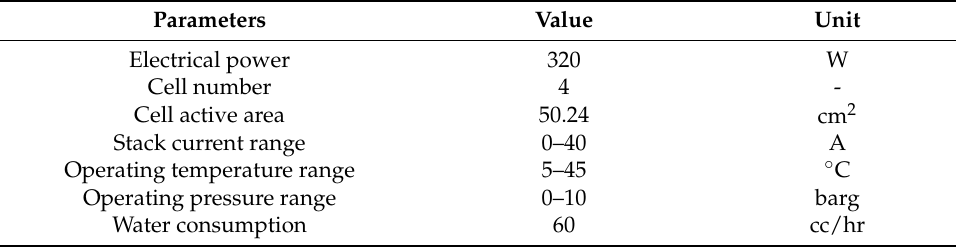
Figure 1. 300 W class PEM water electrolysis stack used in the experimental apparatus. Table 1. Specifications of the PEM Figure 2. The balance of the plant for operating the PEMWE stack consisted of a DC power supply, reservoir, water pump, water trap, heat exchangers, mass flow meters (MFCs),